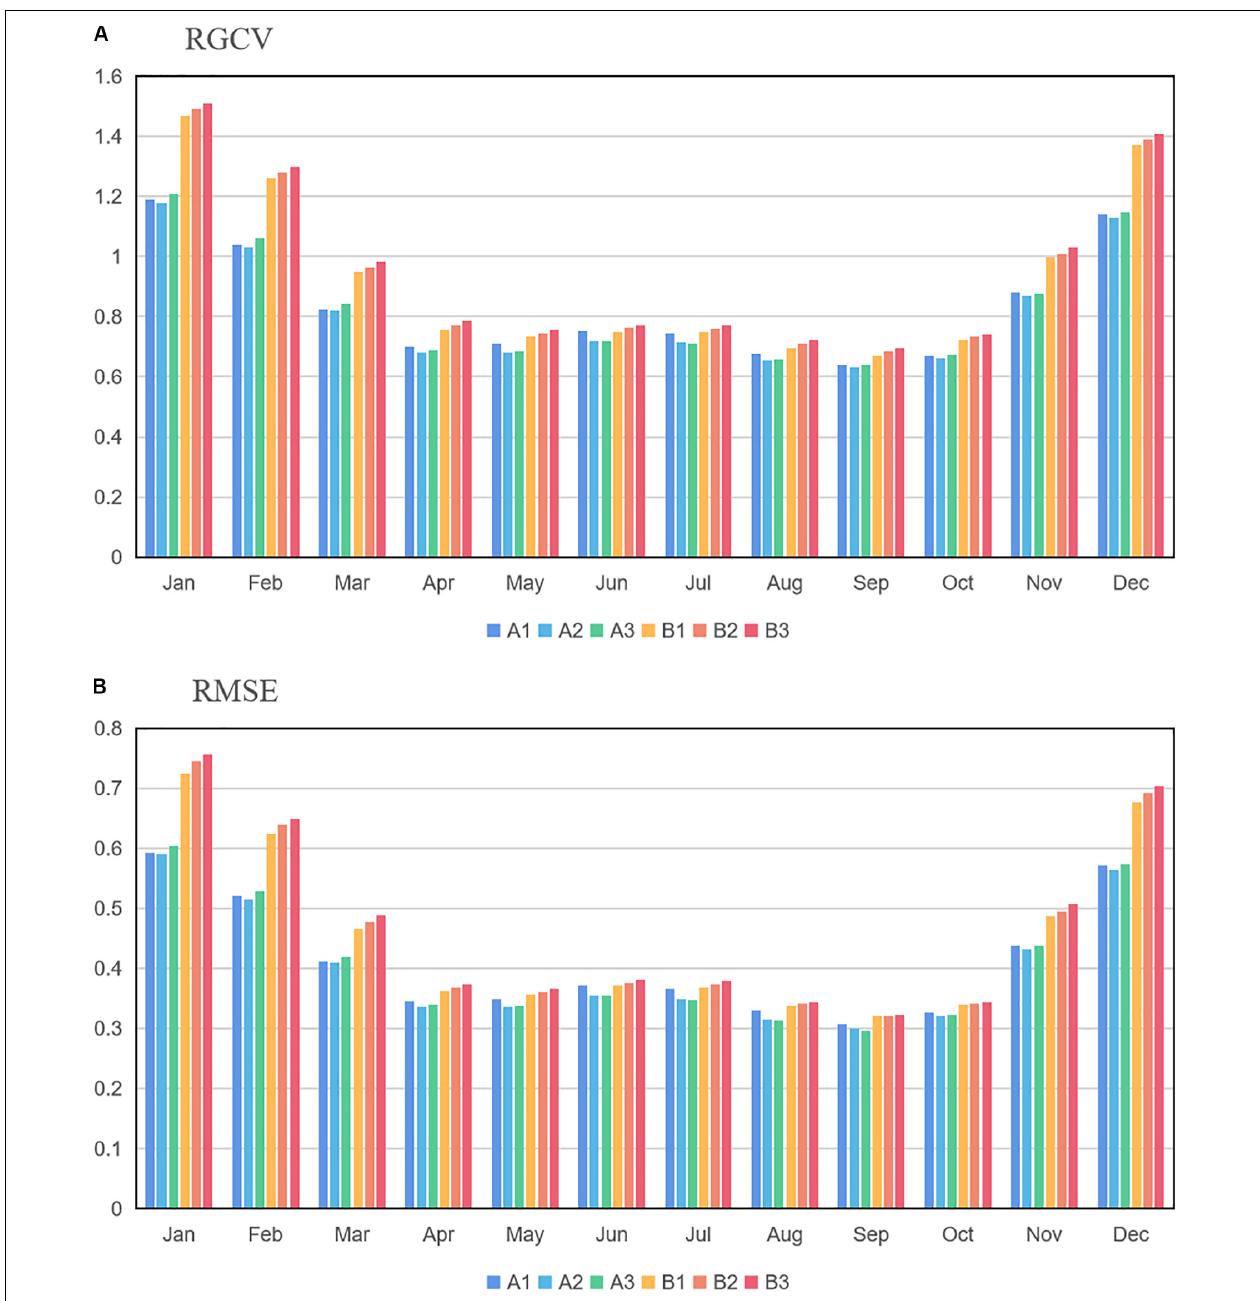
FIGURE 3 | Monthly RGCV (A) and RMSE (B) of the six test experiments ( ◦ C).